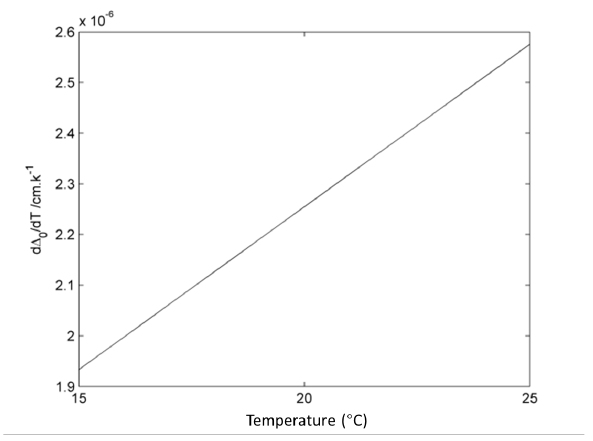
Figure 3. The variation of d ∆ 0 /dT with